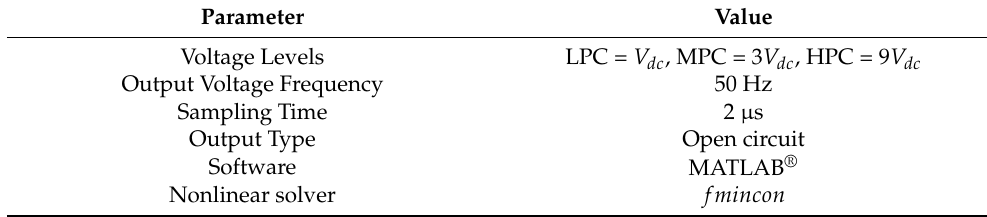
Table 2. Simulation parameters.